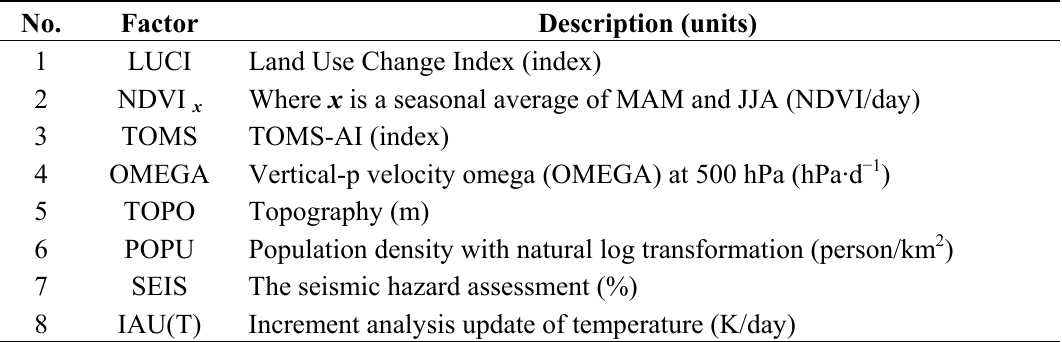
Table 1. The different factors employed in the different regression models. Factors 1–7 serve as predictors (independent), while 8, the IAU (T), serves as the predicted variable (dependent). MAM, March, April and May; JJA, June, July and